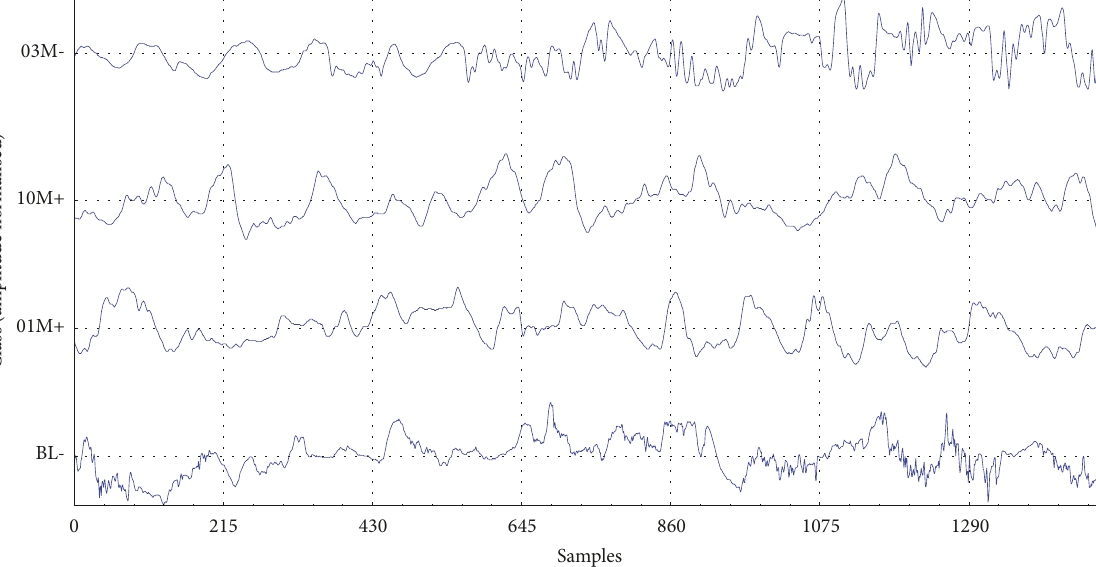
Figure 2: Example of processed glycaemia records from the database. Single missing samples were linearly interpolated, longer missing epochs were removed, and shorter than 5 day-time series were discarded. Samples were taken from the central part of the records to avoid border effects. All these constraints are well featured in the changes that can be pinpointed with record 01M+ in this and previous Figure 1. Records corresponding to baseline, 1 month, 10 months, and 3 months after DJBL removal, are depicted. Sampling frequency was 5